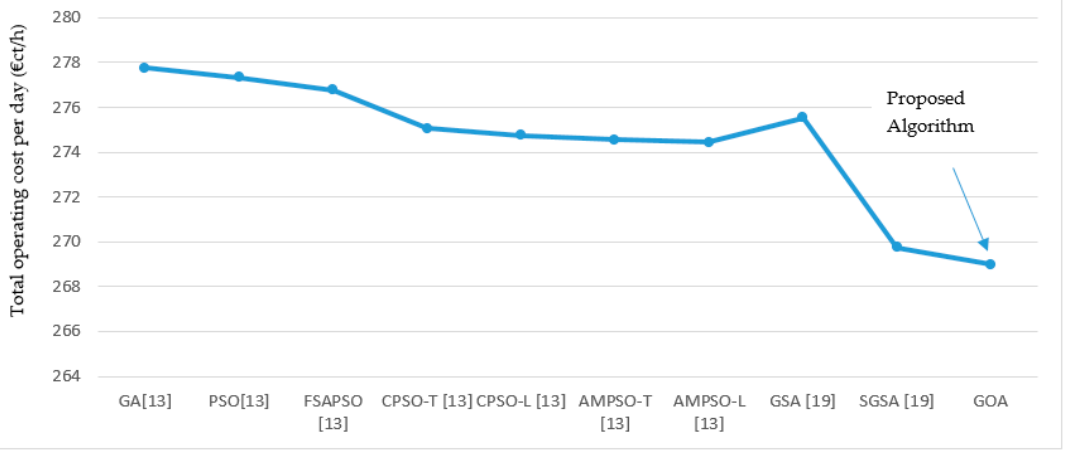
Figure 17. Comparison of the simulation results for the first scenario.